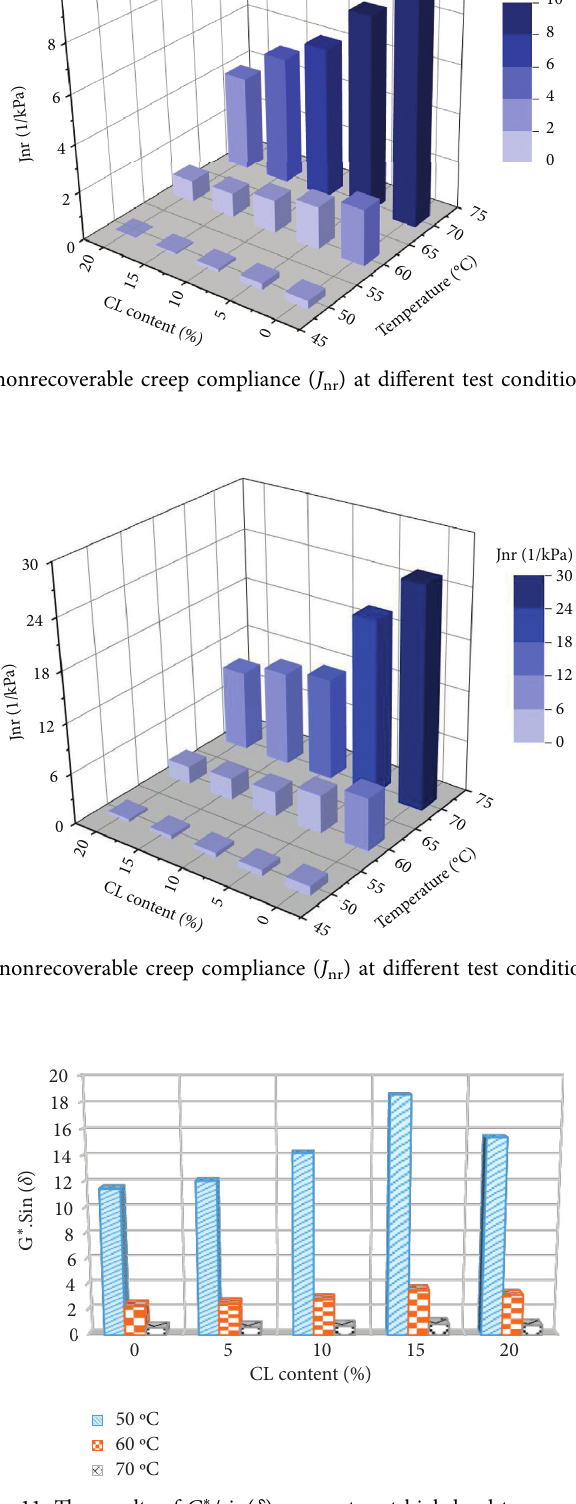
Figure 11: The results of G ∗ /sin( δ ) parameter at high-level